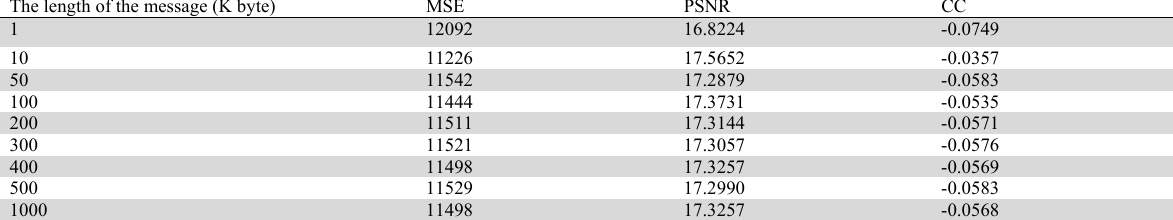
Long messages cryptography (quality parameters) The length of the message (K byte)